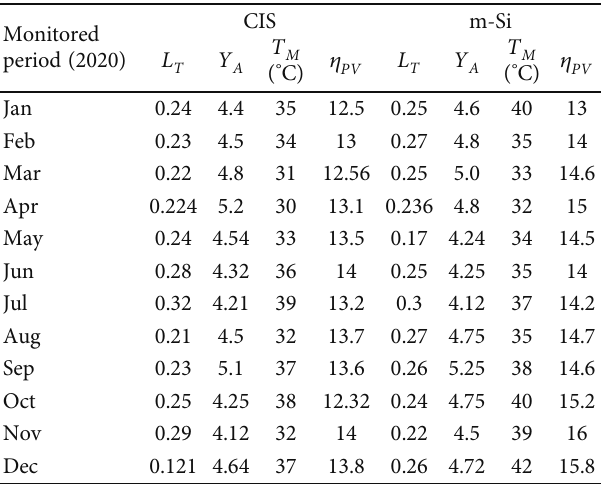
Table 8: Temperature loss, PV e ffi ciency, and array yield ’ s monthly variation for PV